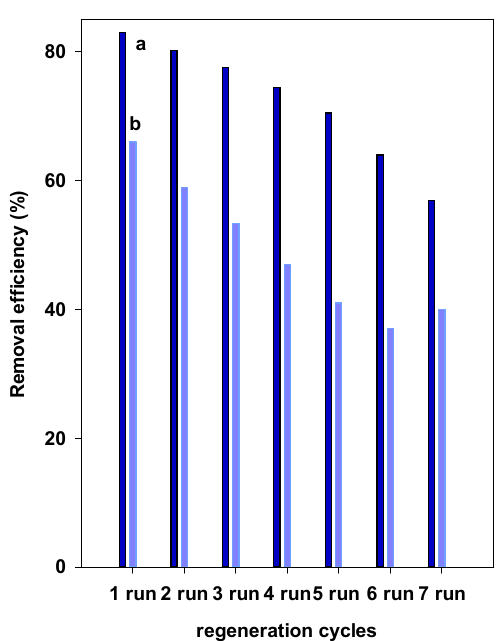
Figure 12. Regeneration properties of ( a ) Zr-PCH and ( b ) Al-PCH materials.